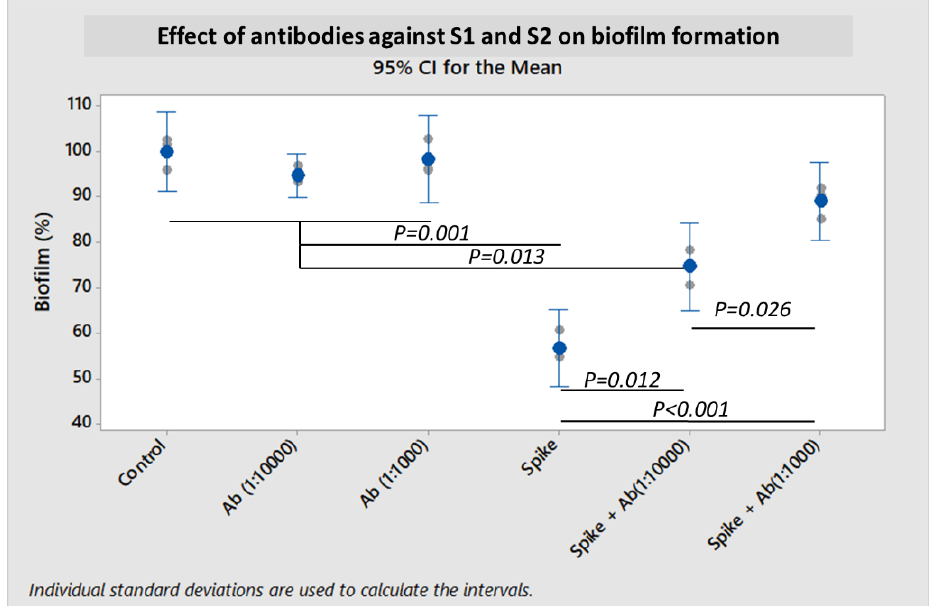
Figure 5. Effect of co-incubating SARS-CoV-2 spike S1 and S2 antibodies with spike S1 + S2 protein